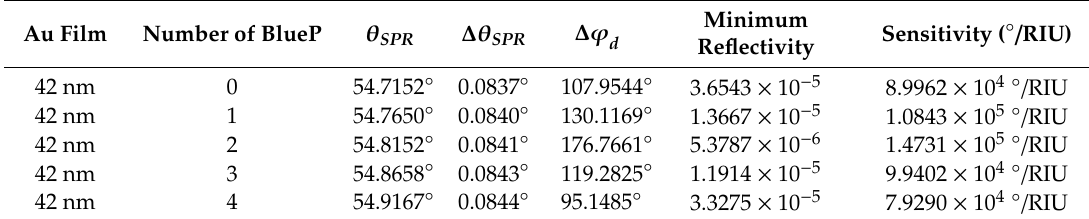
), minimum reflectivity, and sensitivity. d